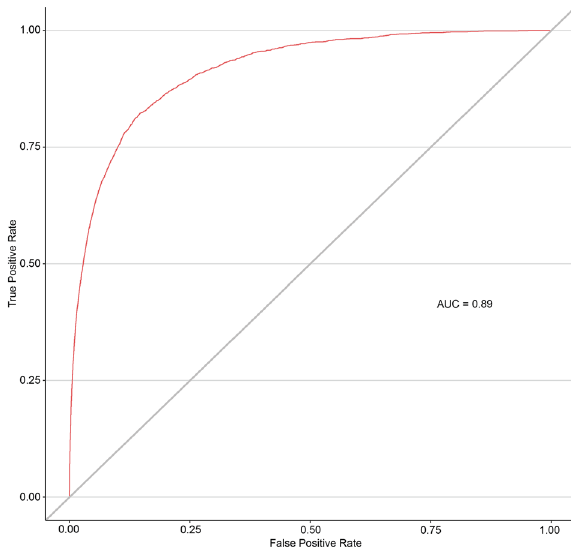
Fig. 2 Test data accuracy, calibration curve with Briers score. The red line is the calibration curve; the grey line represents a perfect fi